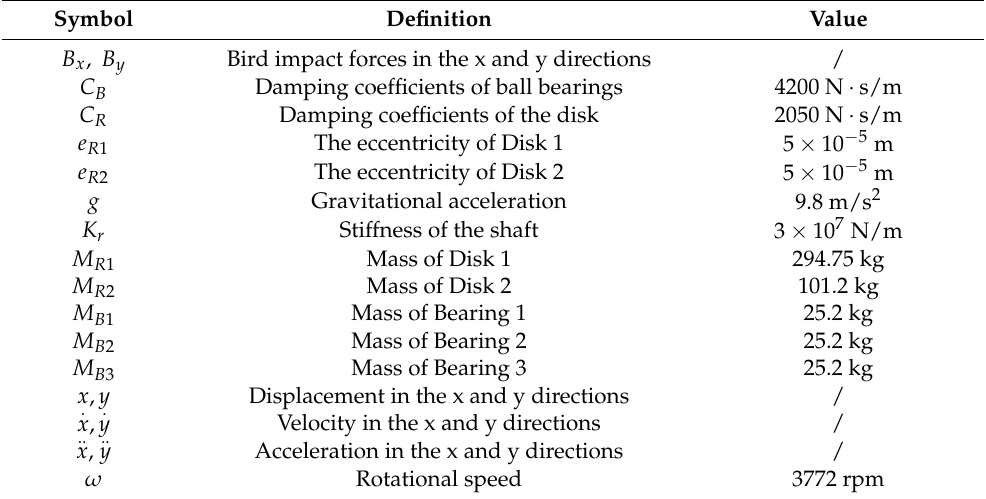
Table 3. The definitions and values of rotor system parameters. Symbol Definition Value B x , B y Bird impact forces in the x and y directions / Damping coefficients of ball bearings 4200 N · s/m Damping coefficients of the